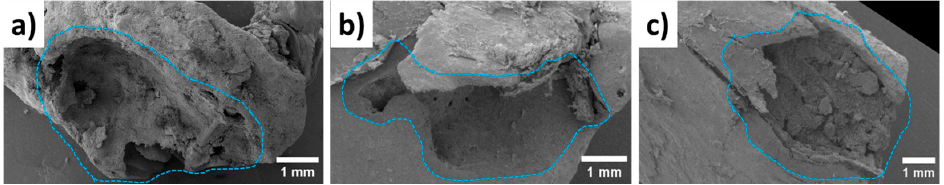
Figure 14. Bones’ microstructures ( a ) 1 month, ( b ) 3 months, and ( c ) 6 months after the operations. The light blue dashed areas indicate the locations of the implants.